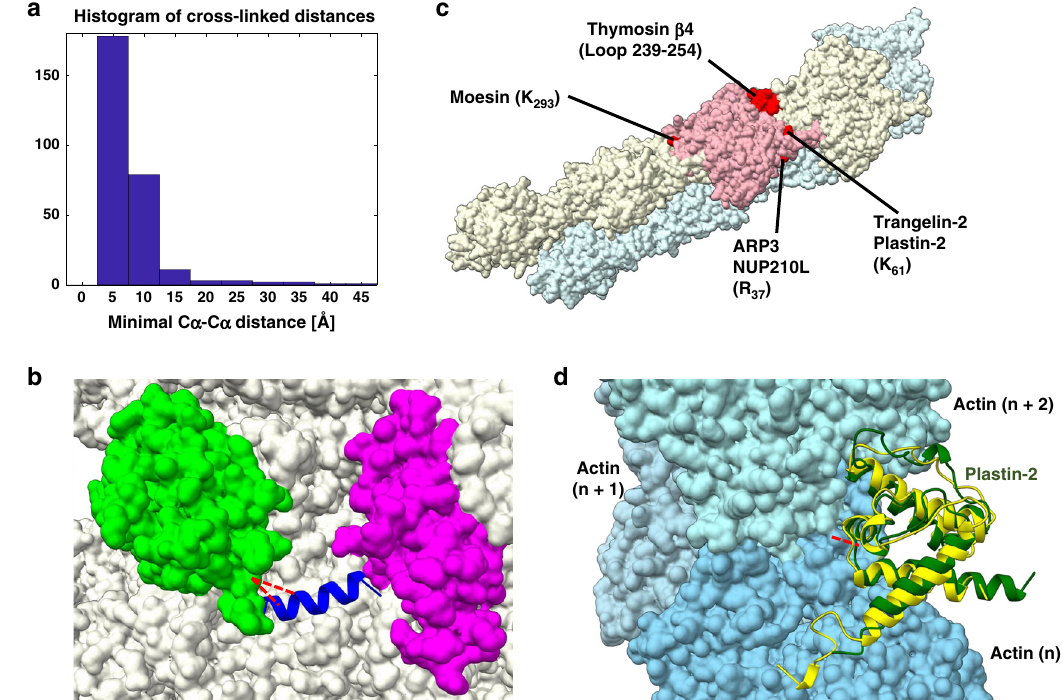
Fig. 4 In situ FA cross-linking of human PC9 cells in culture. a Histogram of the distances spanned by in situ cross-links in cases that could be mapped onto solved atomic structures. The PDB IDs used for calculating these distances are listed in Supplementary Data 3 for each cross-link. b Docking model of the binding helix of β NAC (blue) on the outer surface of the S80 ribosome (PDBid 6EK0 39 ). The docking was constrained by two cross-links (red) to ribosomal protein L22 (green). Ribosomal protein L31 (magenta) was shown previously to interact with β NAC as well 29 . c A view of the actin fi lament (PDBid 6D8C 31 ), with one of its monomers marked in pink. Cross-links between actin and several of its regulators all map to the outer surface of the actin fi lament (red). d Docking model (green) of the CH3 domain of plastin-2 onto the actin fi lament. The docking was constrained by a single cross-link (red) between plastin-2 and actin. The model is similar (3.2 Å RMSD) to a recent cryo-EM structure (PDBid 6D8C 31 ) of the homologous protein fi lamin A (yellow), which was assembled on the fi lament in vitro. Source data are provided as a Source Data fi le.